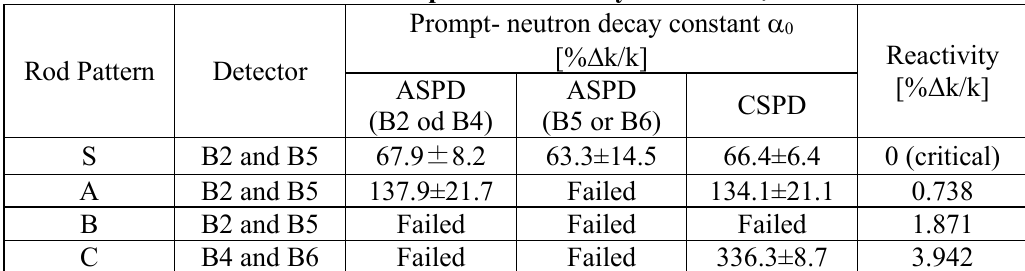
Figure 8. Cross - power spectral density between B4 and B6 in rod pattern C (subcritical state). The prompt-neutron decay constants inferred from the correlated reactor noise components of the cross and auto-power spectral density are summarized in Table II . Table II. Prompt-neutron decay constant  